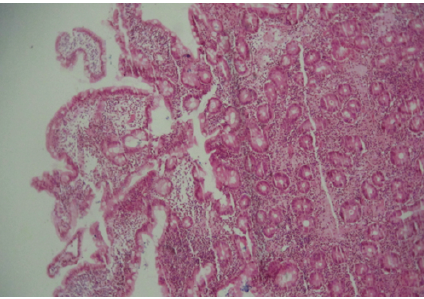
Figure 1: Histologic examination showing a moderate lymphocyte infiltration expanding villus axis and lamina propria. H&E stain ( × 200).